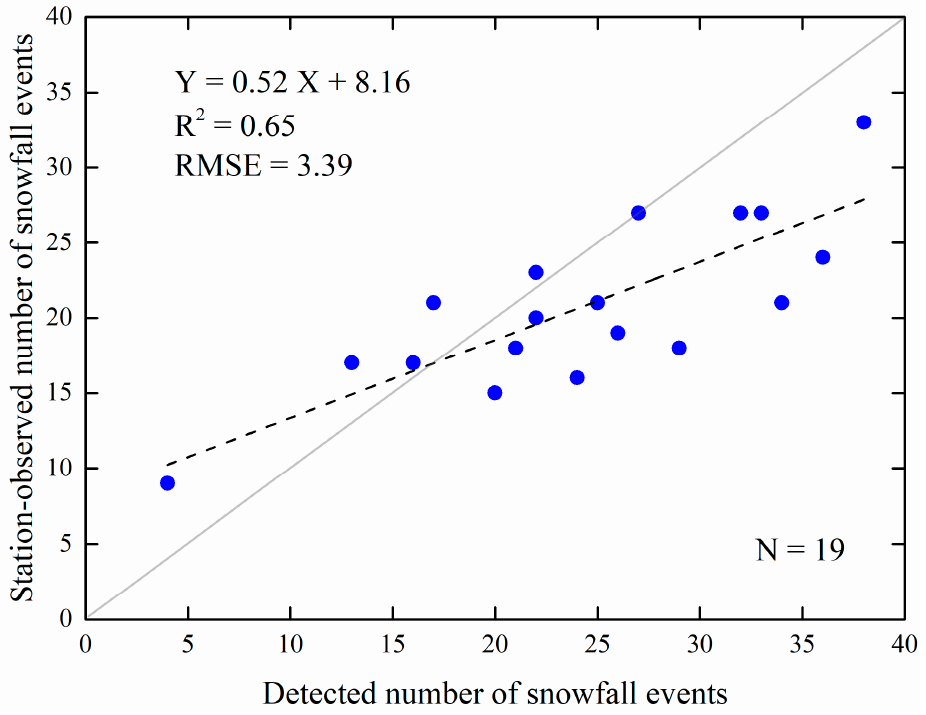
Figure 6. Comparison of annual detected numbers of snowfall events using MODIS and observations from the Bayanbulak meteorological station for each hydrological year from 2000 to 2018. The dashed line denotes the best-fit line from linear regression. The coefficient of determination (R 2 ), root mean square error (RMSE), and sample size (N) are also given.